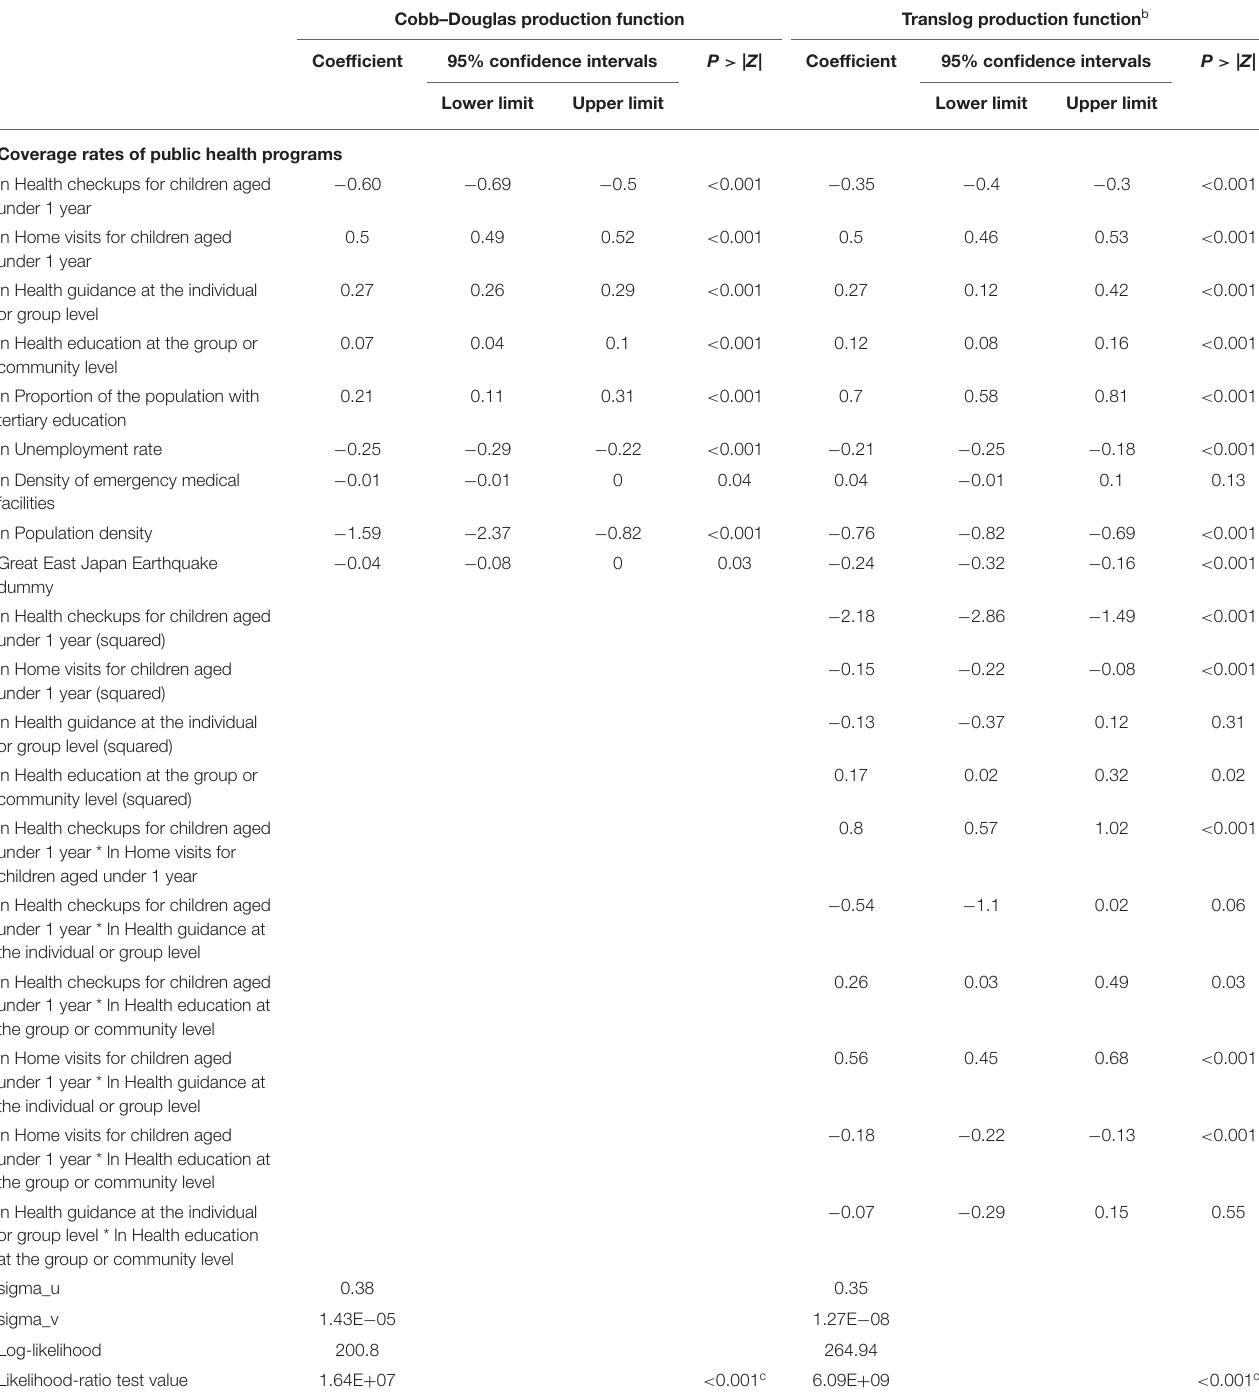
TABLE 2 | Estimated production function using a true fixed effects model ( N = 47 for 17 years) a